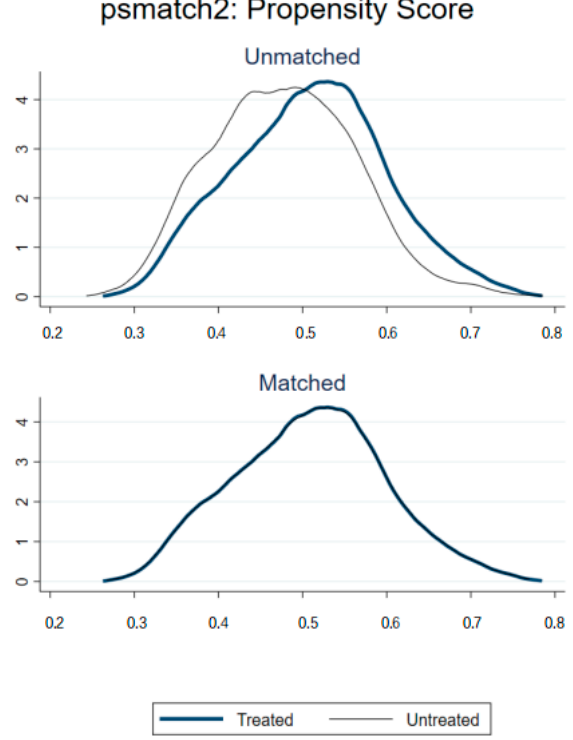
Figure 1. The kdensity density distribution before and after sample matching.